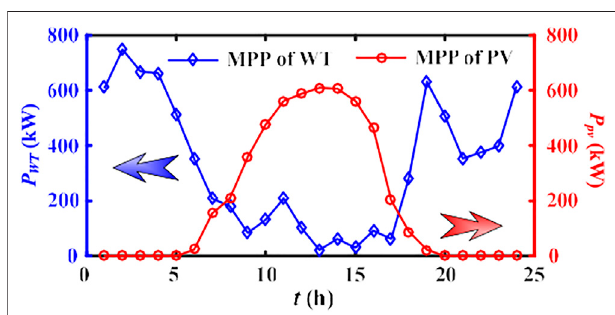
FIGURE 13 | Output of DGs under MPPT control.